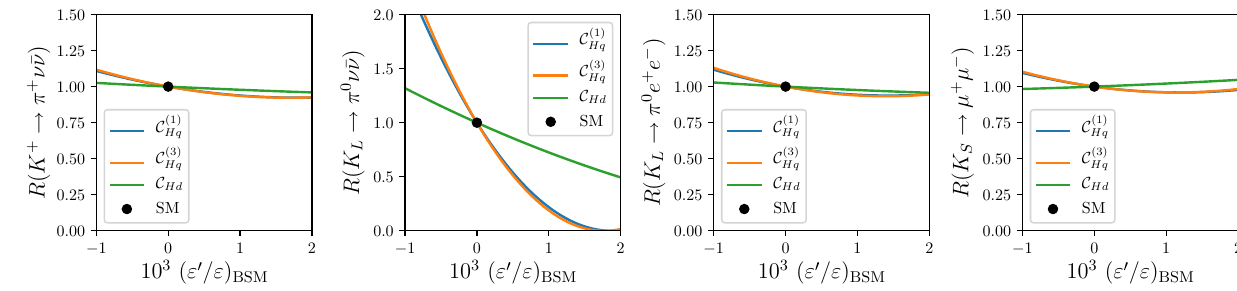
Fig. 4 Correlation between ε (cid:2) /ε , K + → π + ν ¯ ν , K L → π 0 ν ¯ ν , K L → π 0 e ¯ e , and K S → μ + μ − from imaginary NP effects in individual SMEFT operators of type ψ 2 H 2 D inducing flavour-changing Z 0 couplings. The flavour index “12” has been